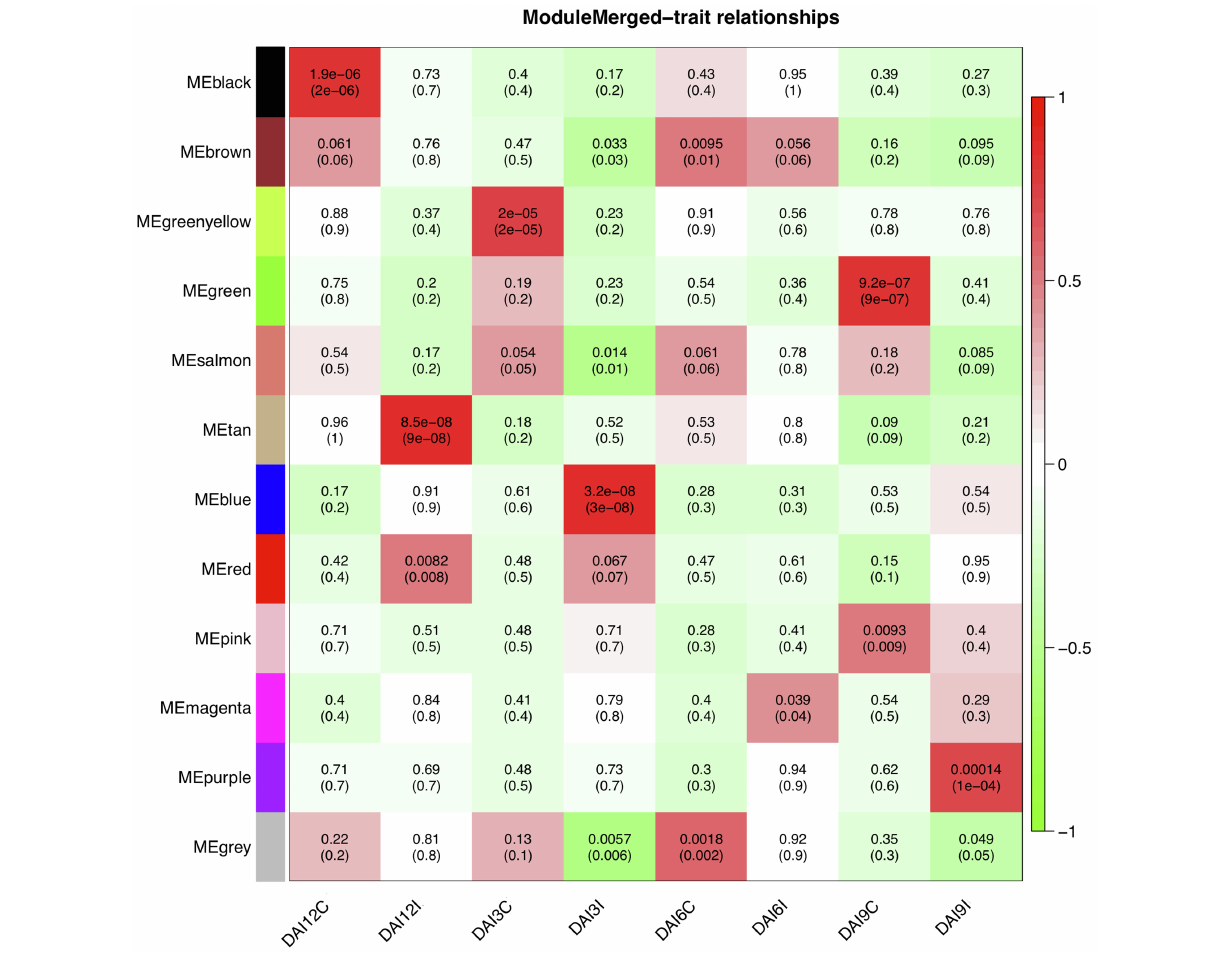
FIGURE 9 | The heatmap of module-traits relationships in RAD. The heatmap illustrates correlations between module eigengenes and DAI traits. The numbers represent Pearson’s correlation coefficients and p -values. The color legend represents the strength and direction of